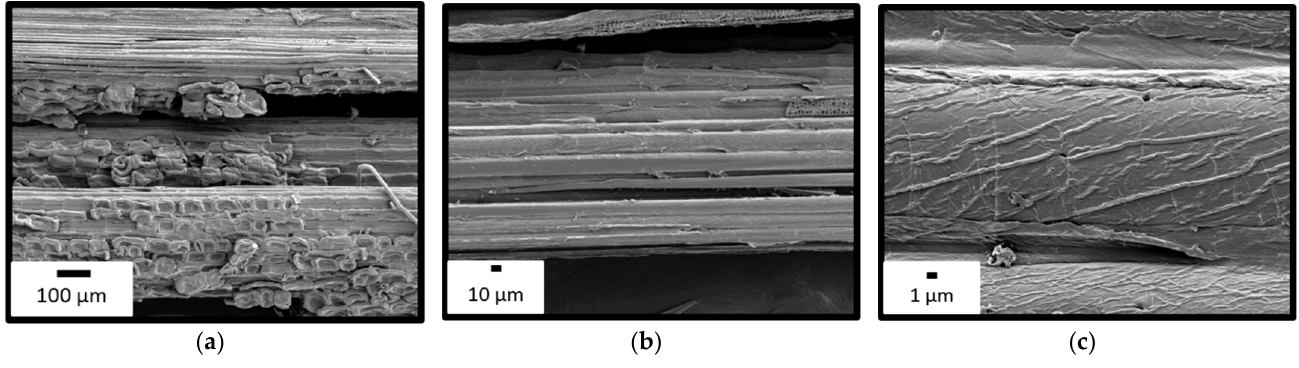
Figure 1. SEM images of fibers extracted in the laboratory at different magnifications: ( a ) Wick of technical fibers; ( b ) Technical fiber (diameter ≈ 400 μ m); ( c ) Elementary fiber (diameter ≈ 20 μ m).